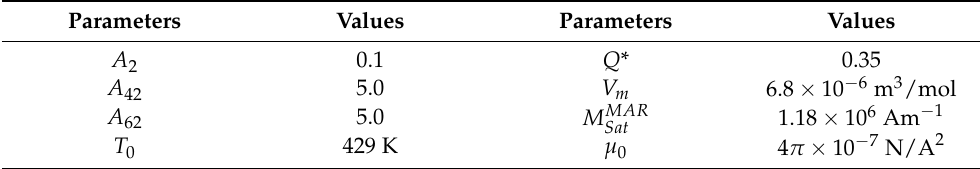
Table 1. Values of the non-dimensional parameters in phase-field